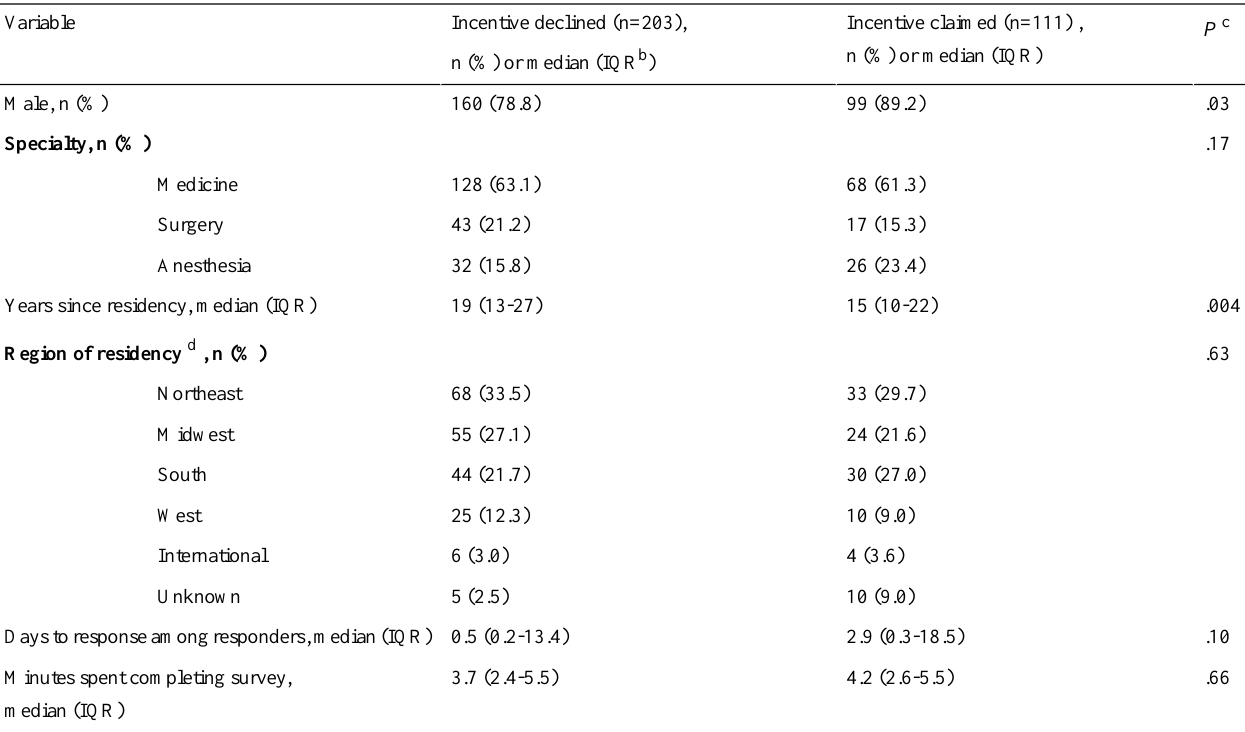
Table 4. Participant characteristics and survey outcomes within the incentive arm of the trial, by participant response to financial incentive a